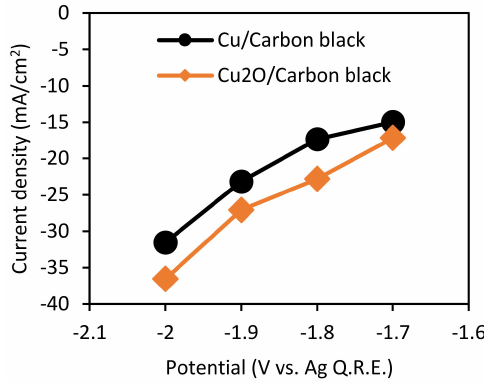
Figure 3. Potential versus current density for CO 2 reduction.